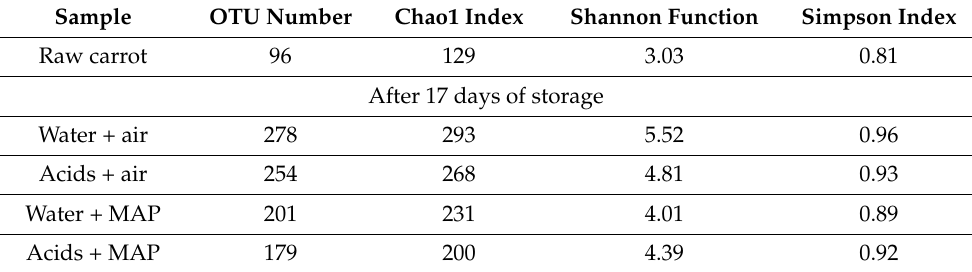
Table 1. Values of α -biodiversity indicators of the carrot metabiome.